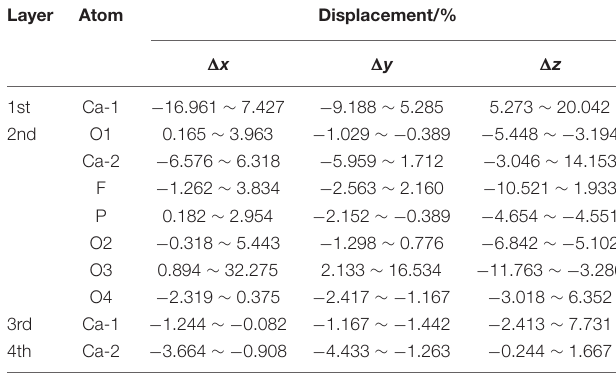
TABLE 4 | Atomic displacements of the fluorapatite (001) surface before and after adsorption.